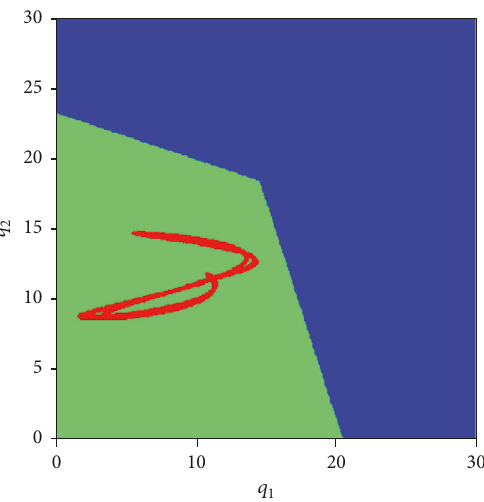
players with demand evaluation bias. Equilibrium output is negatively related to players’ costs; the value of 𝑒 𝑖 is negatively related to range of stability.